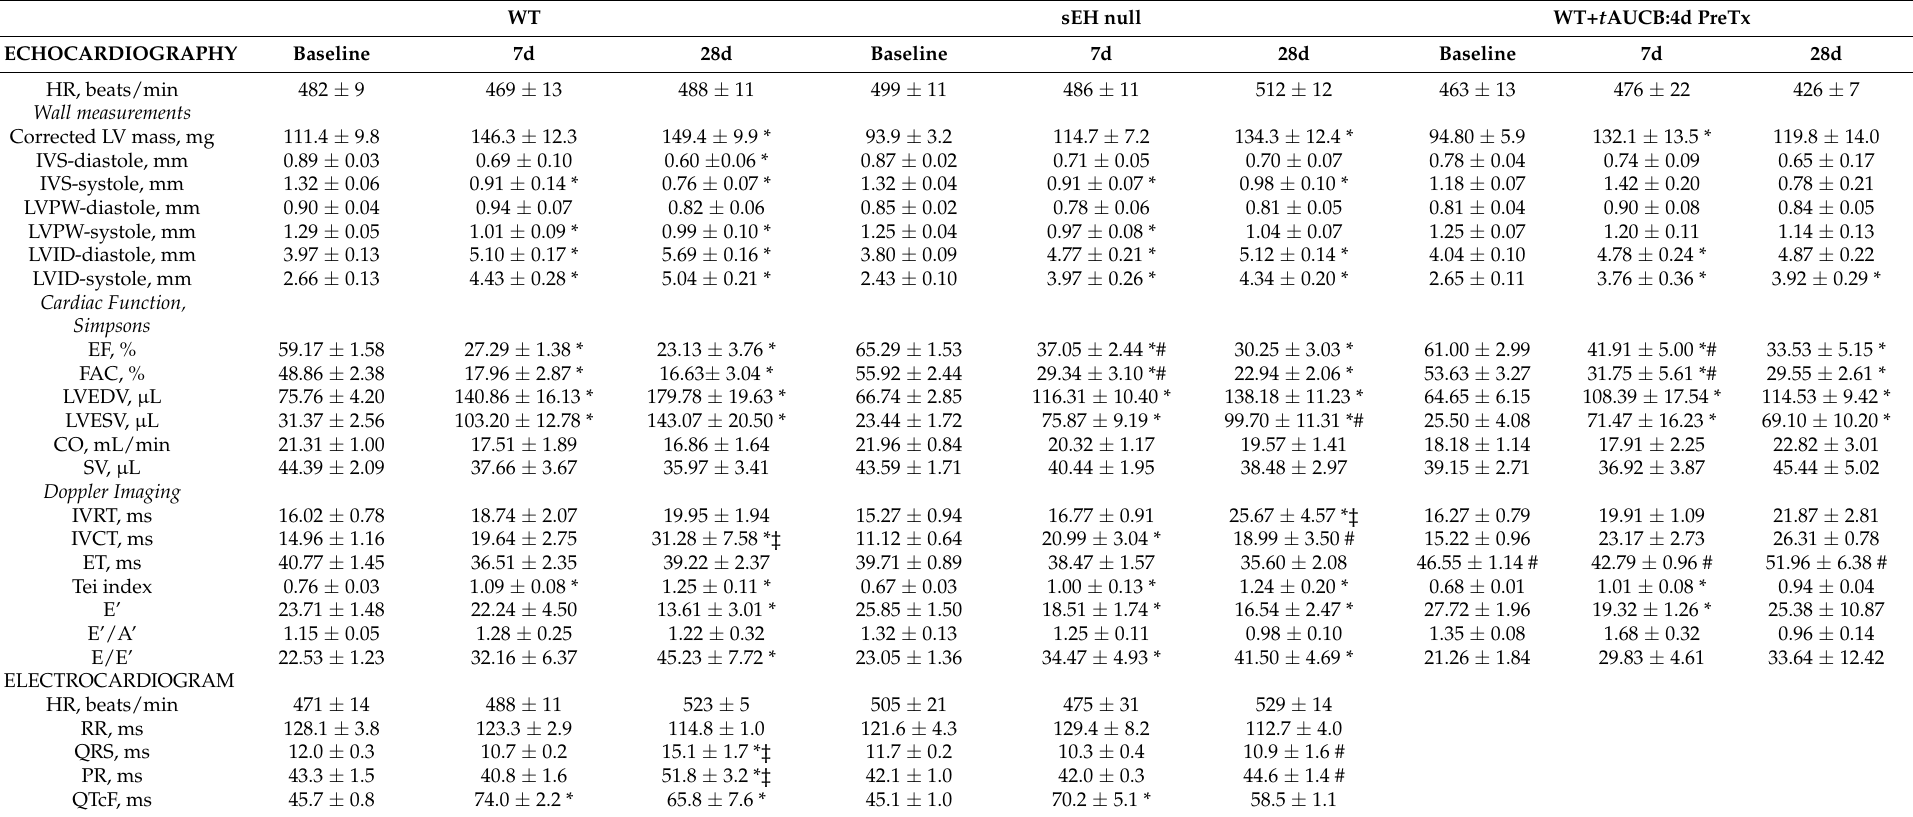
Table 1. Cardiac functional parameters in female mice at baseline, 7, and 28 days post-MI, measured by 2D echocardiography and electrocardiogram. Data are shown as mean ± SEM, n = 5–18. Data from two-way ANOVA with Tukey’s post hoc test. p ≤ 0.05, * vs. baseline; # vs. WT counterpart; ‡ vs. 7 days post-MI. WT WT+ t AUCB:4d